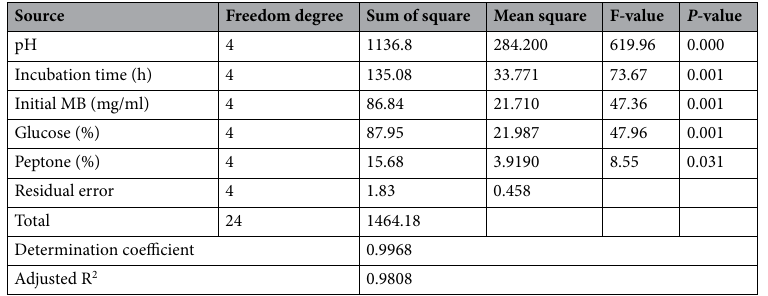
Table 4. ANOVA of MB biosorption by the viable cells of P. alcaliphila NEWG-2 as affected by the tested factors.